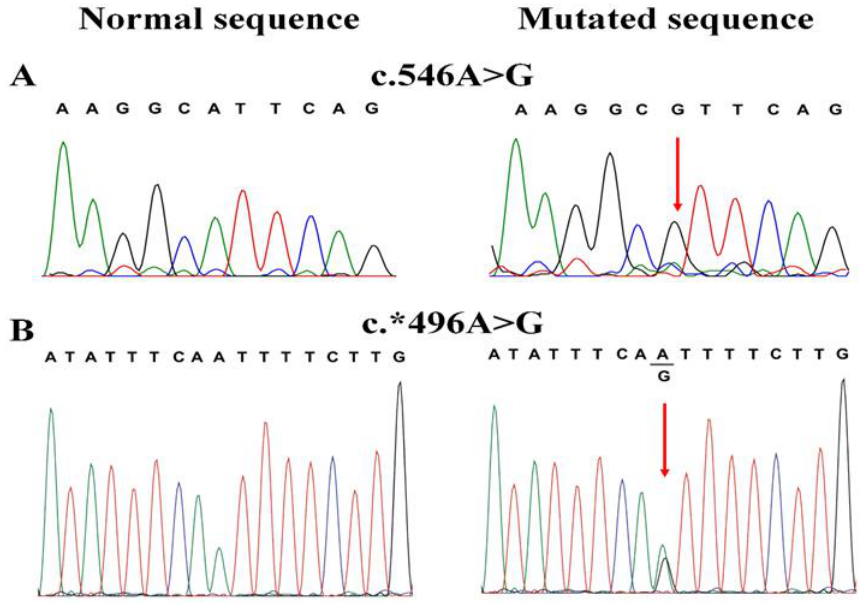
Figure 2. Sequence chromatogram of observed variants. Upper panel ( A ) represents normal and mutated sequence for rs12480307 (c.546A>G) while lower panel ( B ) is of rs76499395 (c.*496A>G) polymorphism.